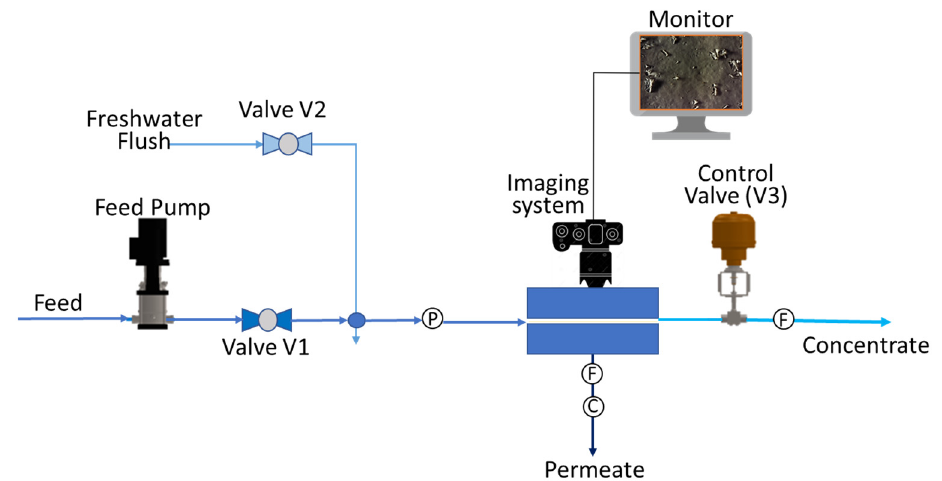
Figure 3. Schematic representation of the plate-and-frame RO (PFRO) membrane monitoring system (MMS). The applied pressure and crossflow in the PFRO unit were controlled via the variable fre- quency drive (VFD) of the feed pump and an automated control valve (V3). Online sensors included feed pressure (P), concentrate and permeate flow rate sensors (F), and conductivity sensors (C).